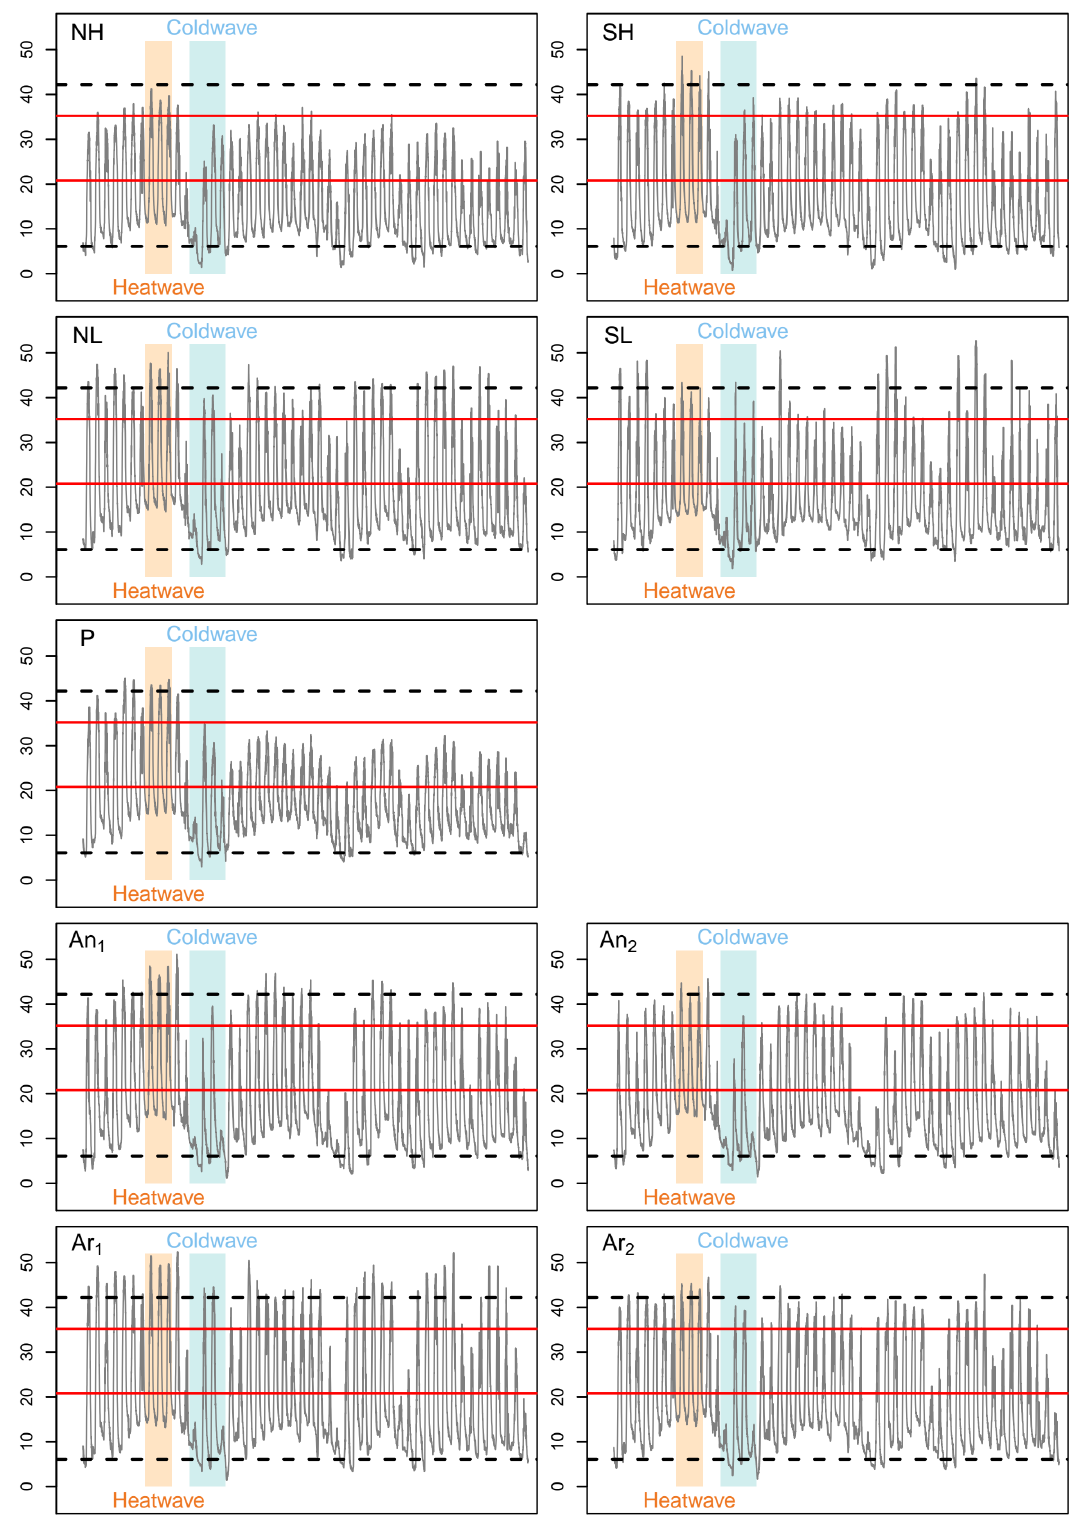
Figure A2. Operative temperatures time series measured on the different study localities in 2019 from 15 July to 2 September. The heatwave from 22–25 July (beige polygon) and the coldwave from 27–31 July (blue polygon) were observed on all sites. The red lines represent VTmin and VTmax which bounds the activity thermal range and the dotted black lines represent CTmin and CTmax which bounds the tolerance thermal